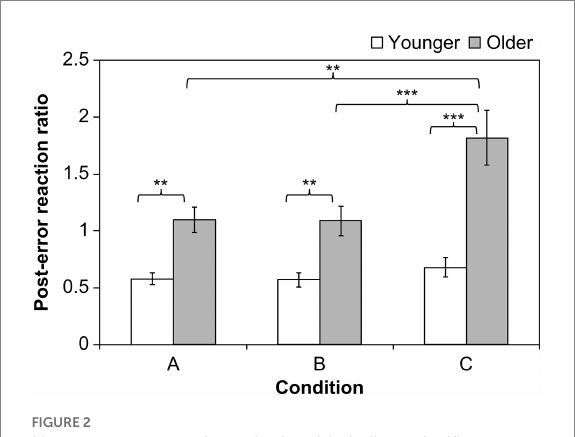
FIGURE 2 Mean post-error reaction ratio. Asterisks indicate significant differences (** p < 0.01, *** p < 0.001). Error bars indicate standard errors.